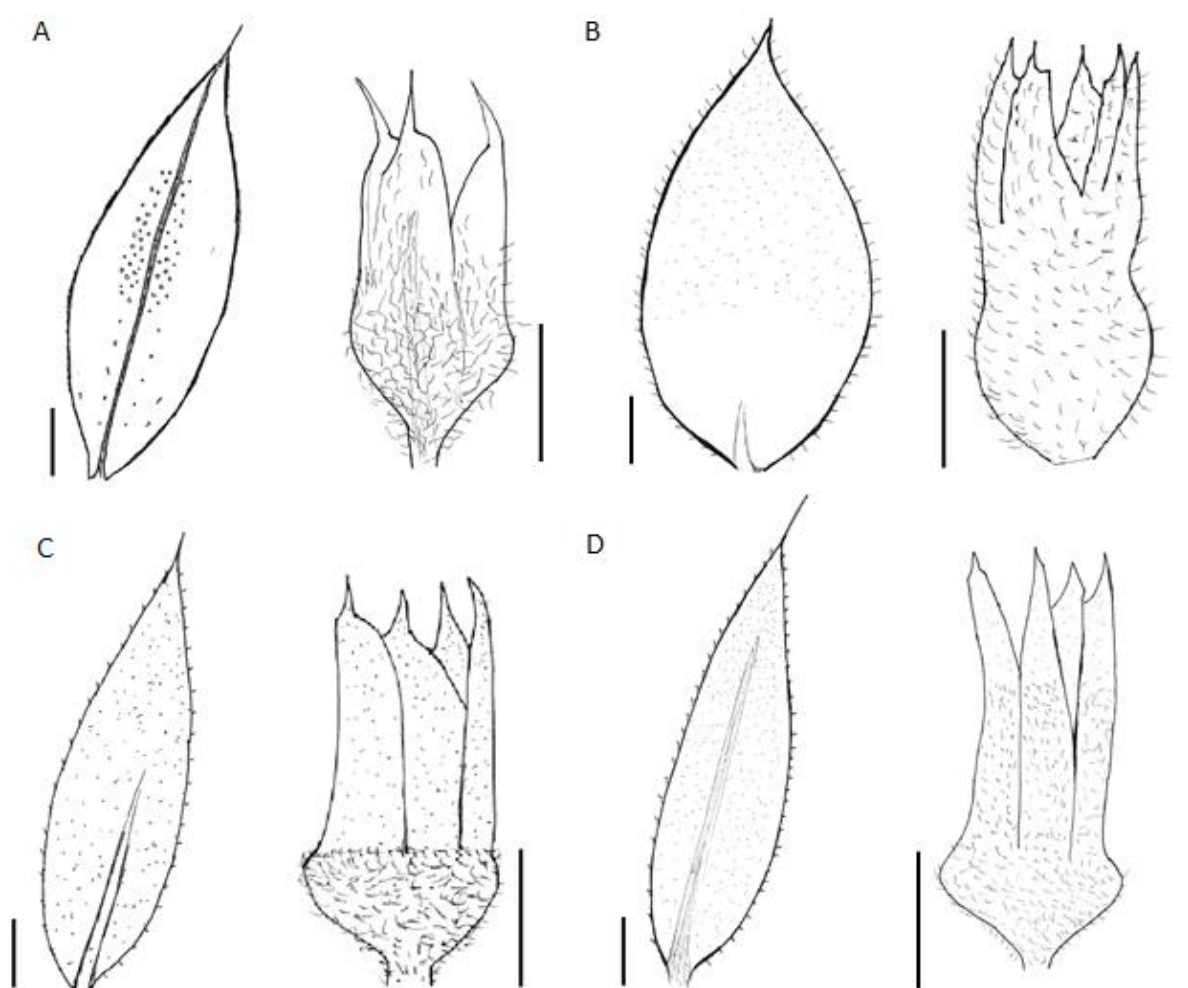
Figure 5. Comparison between leaves and sepals of Paronychia glabra (top-left drawings), P. hieronymi (bottom-left drawings), P. macbridei (top-right drawings), and P. jujuyensis (bottom-right drawings). Scale bars = 1 mm.